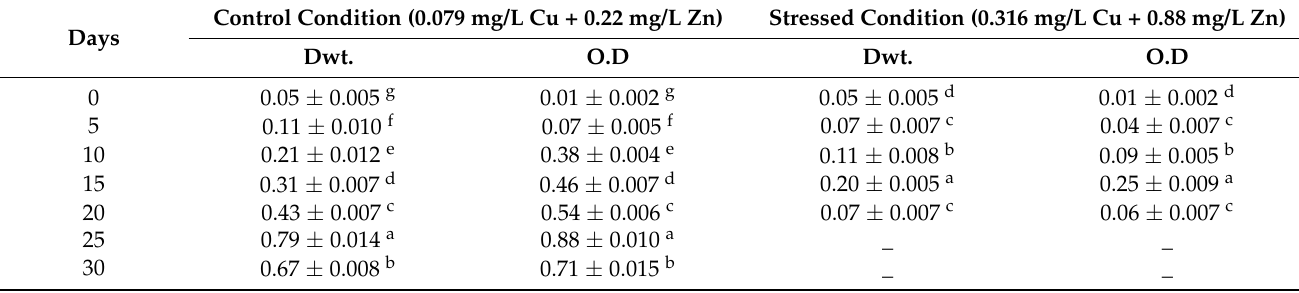
Table 5. Growth rate of Nostoc linckia (as O.D and Dwt). (g/L) grown on BG-110 medium with adjusted Cu and Zn ion concentrations and combined impact of two elements.